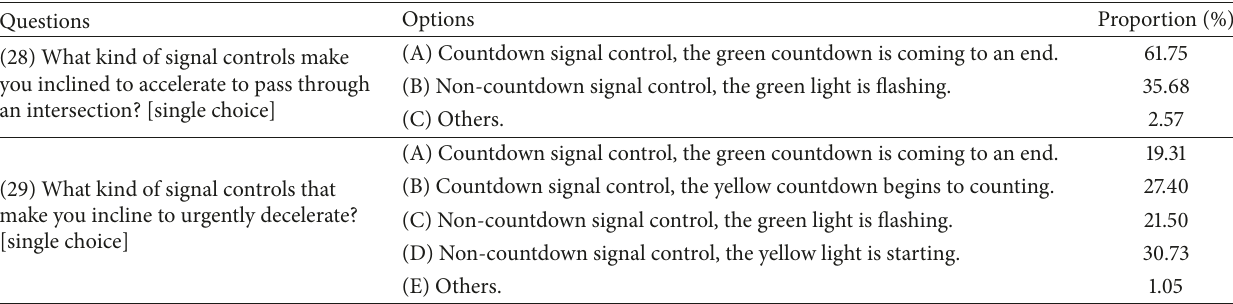
Table 10: Risky driving behaviors at different intersections.